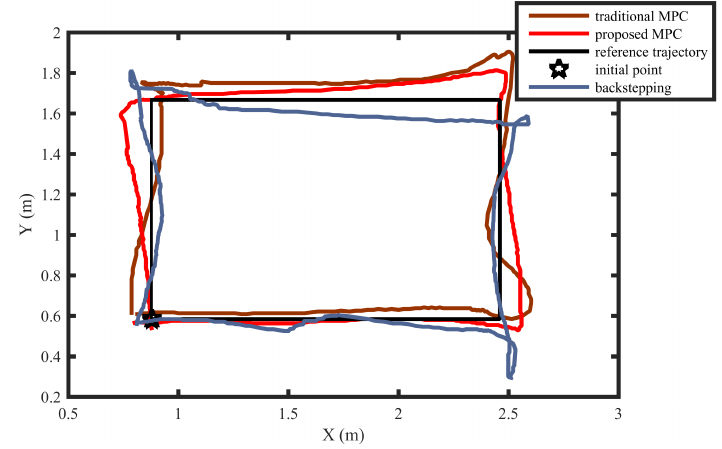
Figure 24. Results of the comparison experiments in square